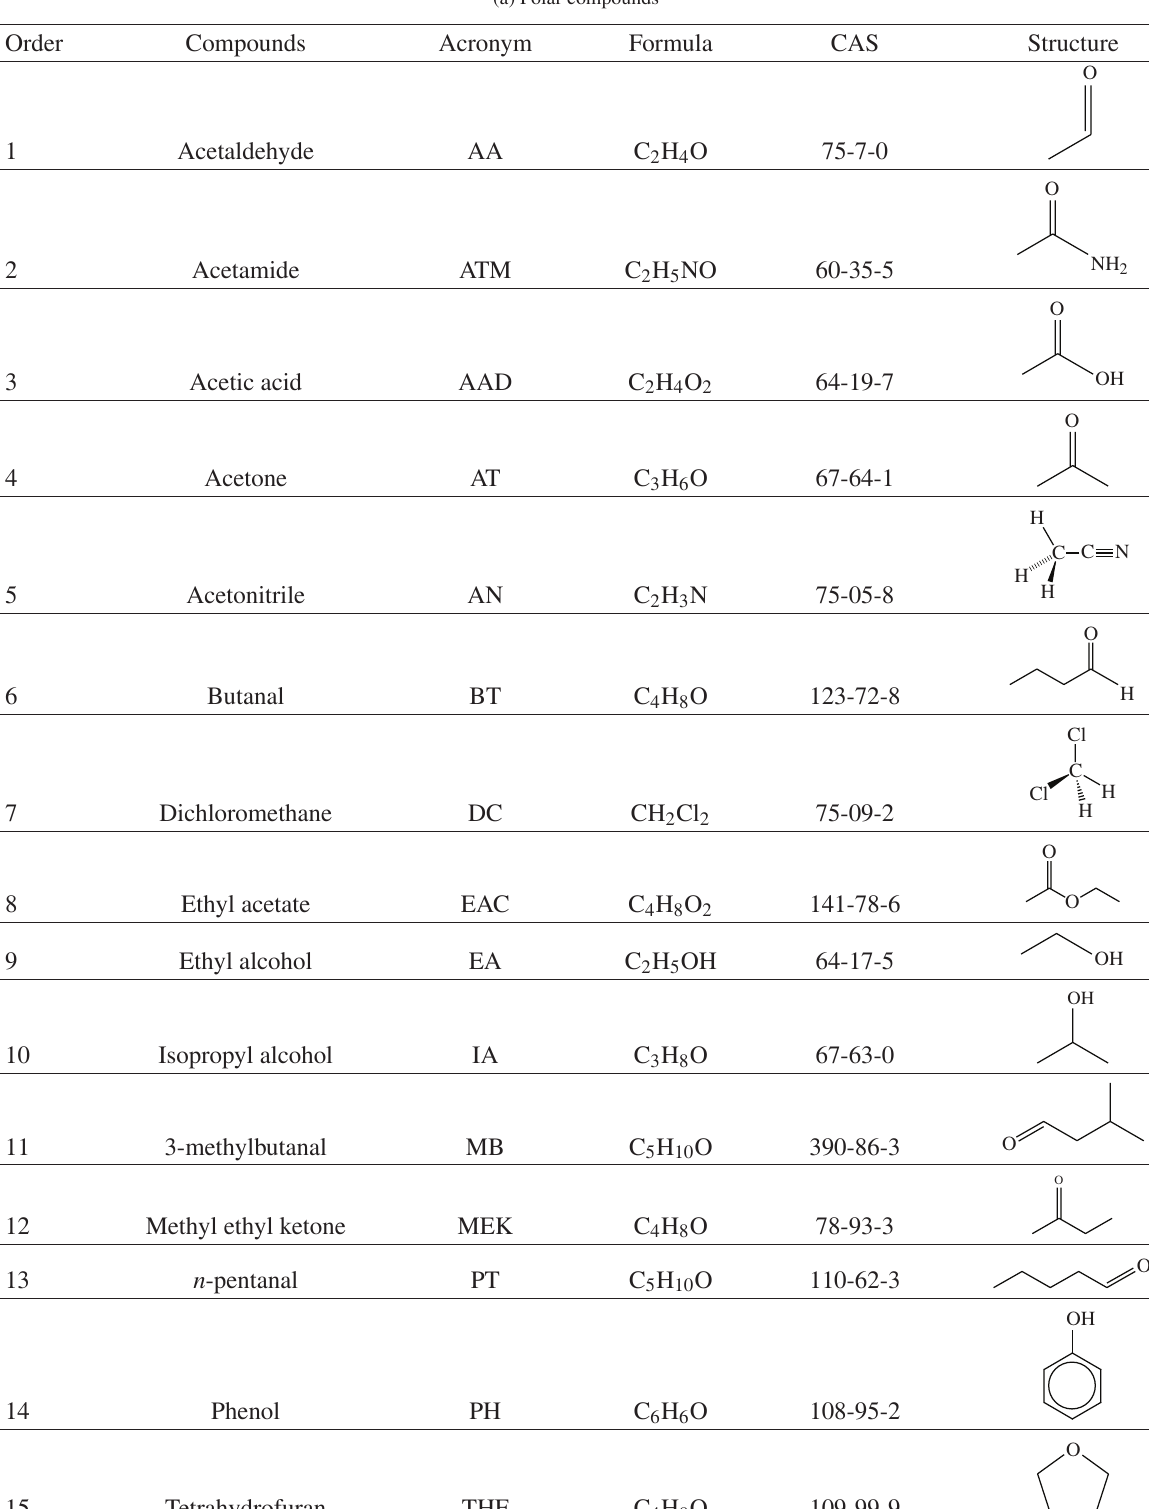
TABLE 1: Basic information of the target volatile organic compounds (VOCs) investigated in this study. (a) Polar